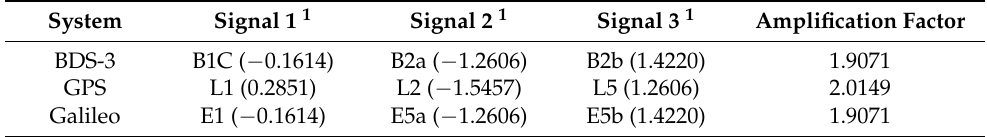
Table 3. The choice of the frequencies used to compute triple frequency (TF) phase combinations and the corresponding coefficient and amplification factor of phase